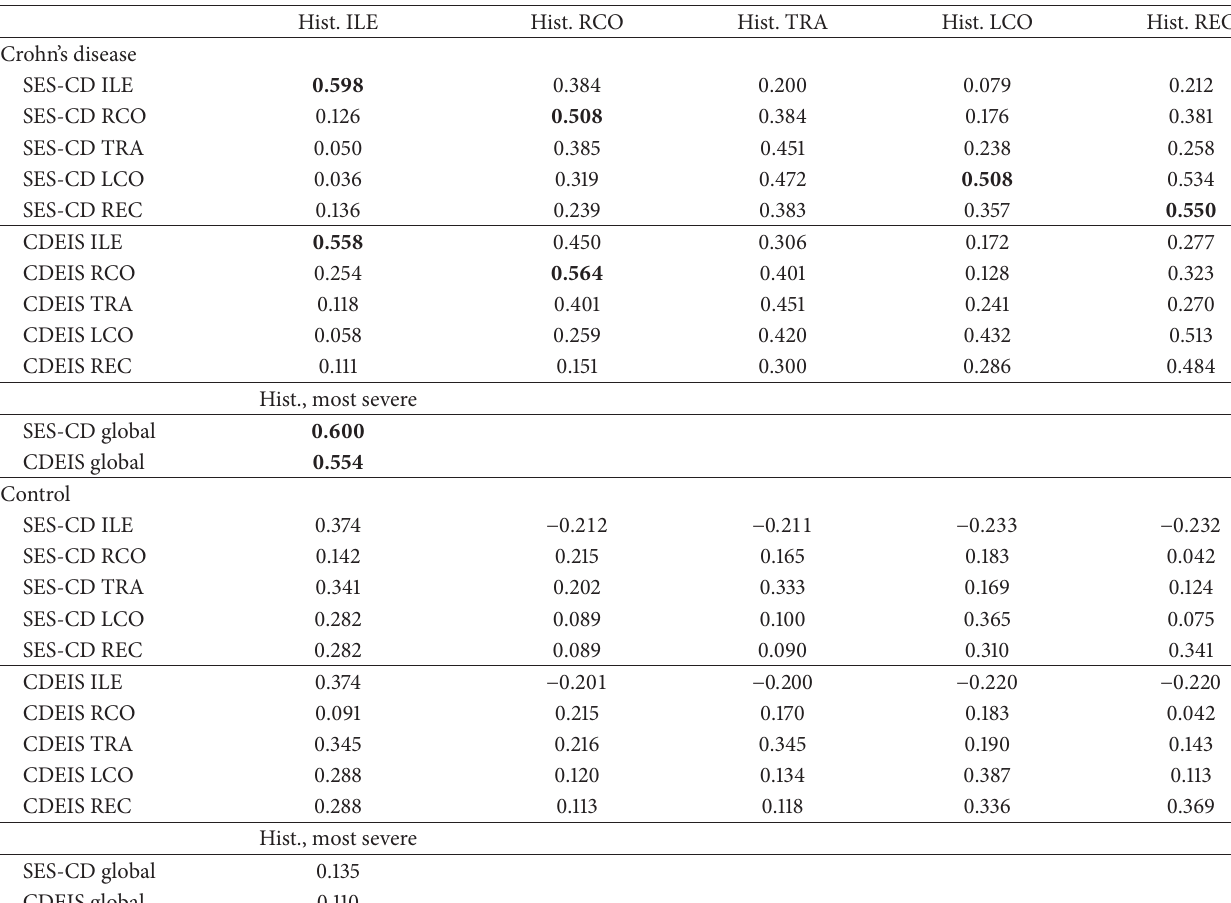
Table 6: Correlations of results for evaluation by histological index (Scoring System for Crohn’s Disease) and two endoscopic indices (Simple Endoscopic Score for Crohn’s Disease and Crohn’s Disease Endoscopic Index of Severity) for patients with Crohn’s disease and the control group. Correlations made in five intestinal segments: terminal ileum (ILE), right colon (RCO), transverse colon (TRA), left colon (LCO), and rectum